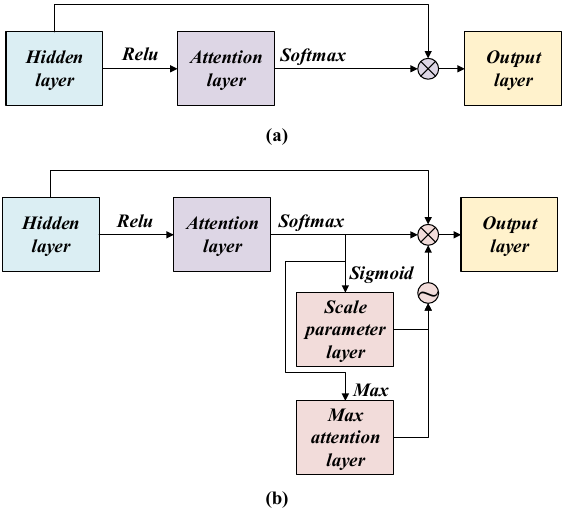
Figure 2. ( a ) Attention structure. ( b ) Adaptive sparse attention